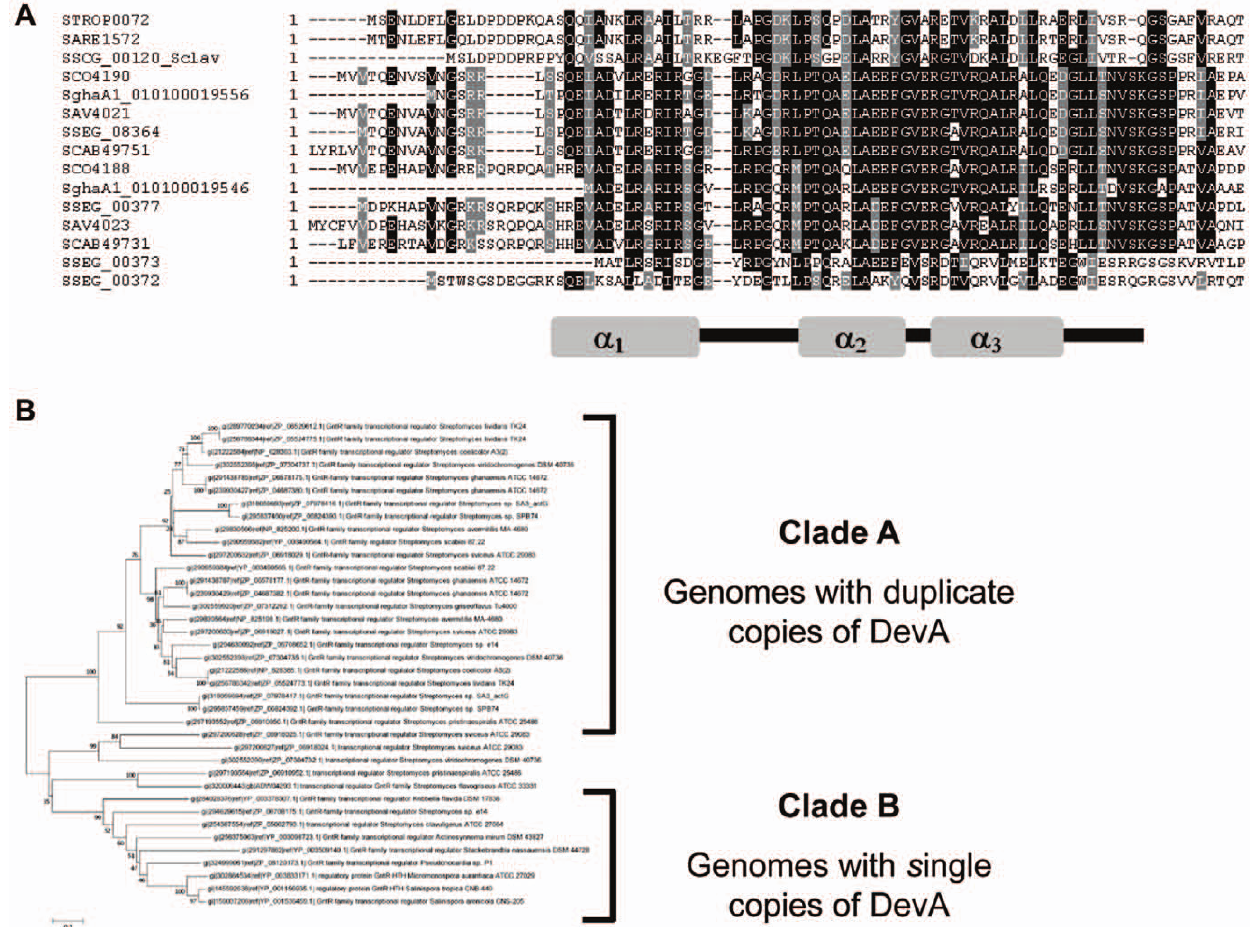
Figure 3. Bioinformatic and evolutionary analysis of devA and its homologues. A: Multiple alignment of the N-terminus of the DevA-like protein sequences. The a -helices (1–3) of the helix-turn-helix motif are shown to indicate the structure based homology. B: A ML tree based on the alignment of whole DevA-like sequences displaying the two main clades (A - duplicates & B - singletons). Please see Table 2 for details on homology and morphology of the